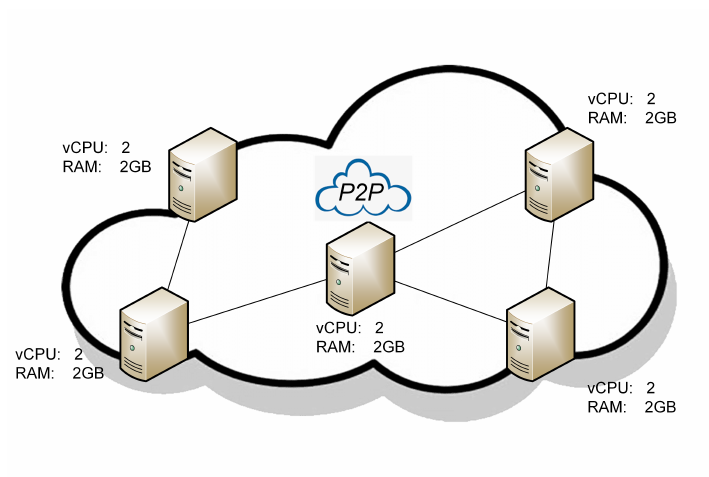
Figure 4. Settings of evaluations.